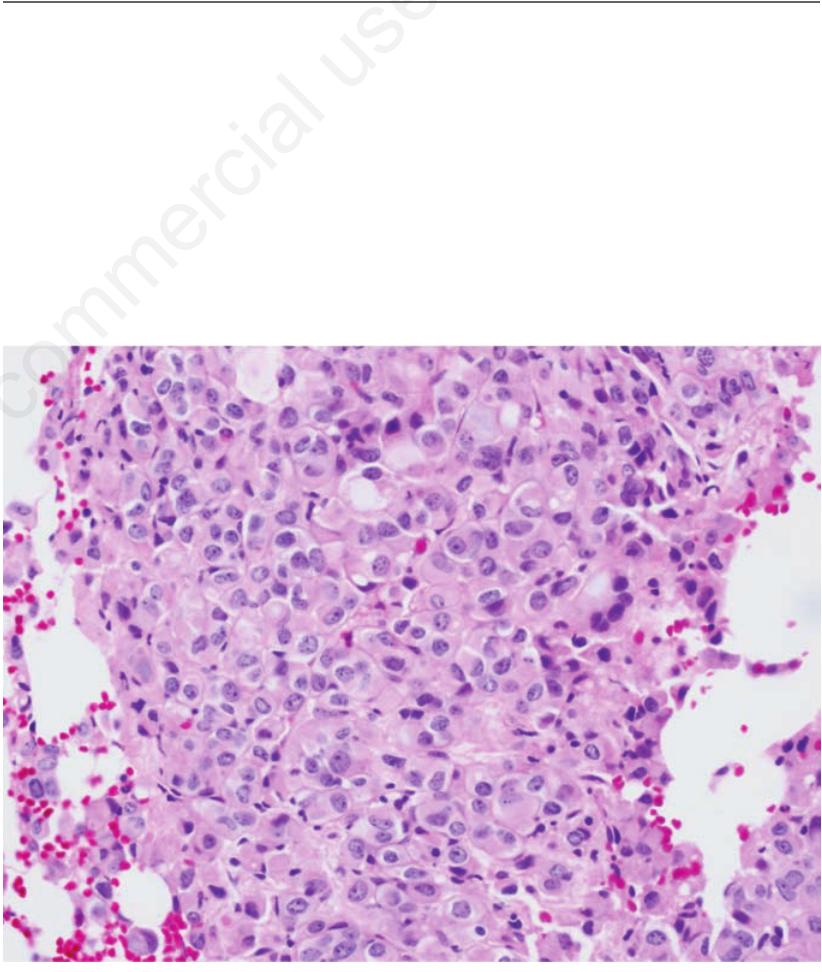
Figure 1. Peripheral blood smear with evidence of intravascular hemolysis.